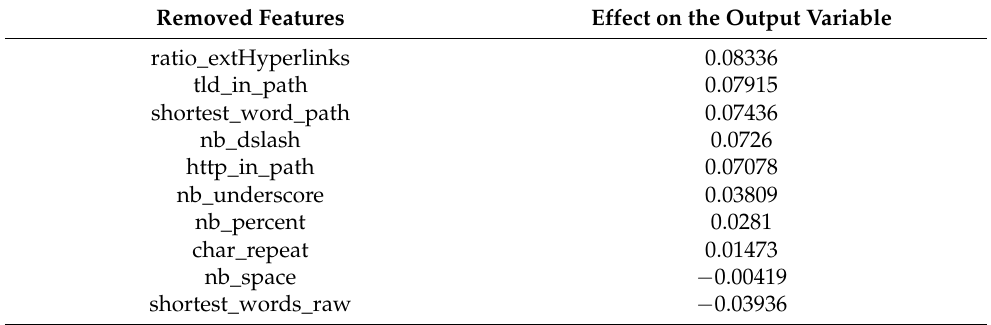
Table 14. List of features removed using Spearman and their effect on the output variable on dataset